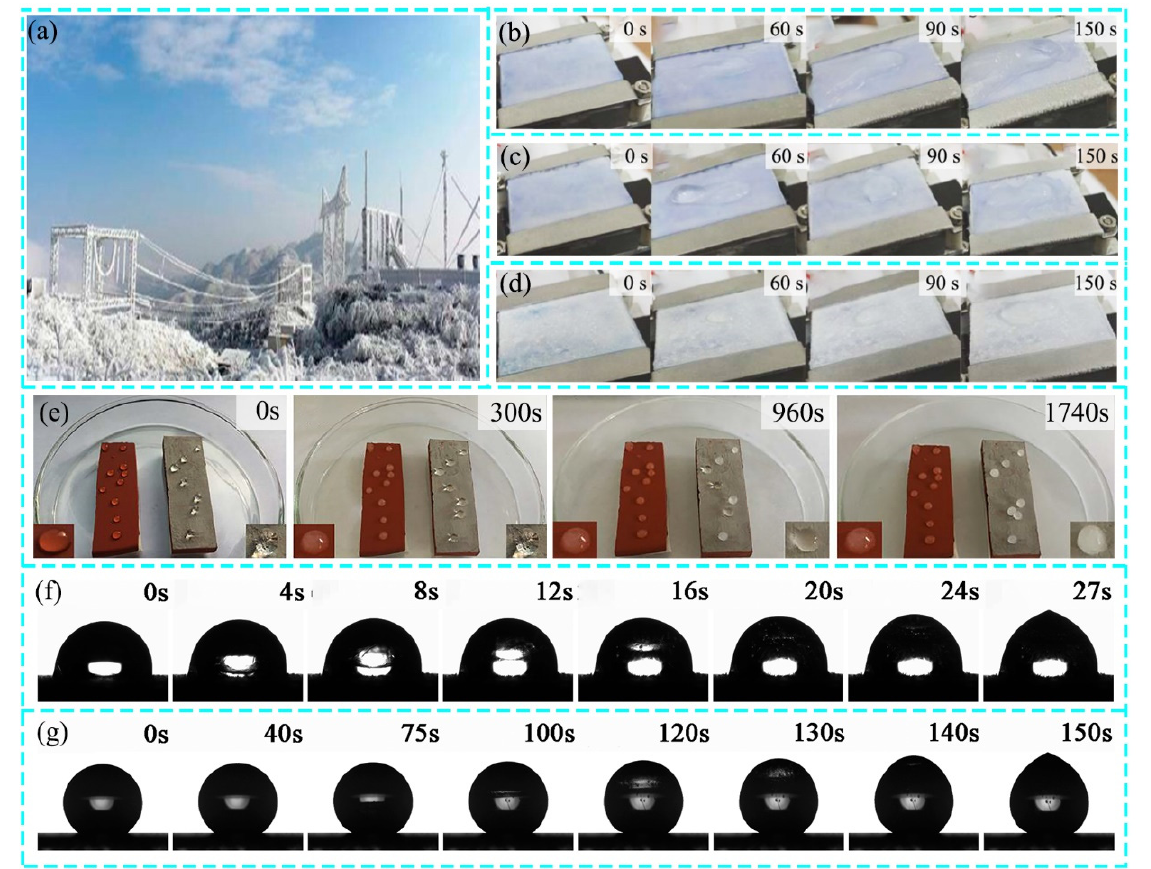
Figure 6. Effect diagram of deicing coating to inhibit icing. ( a ) A power system is damaged by snow. ( b – d ) The freezing speeds of hydrophilic, hydrophobic, and superhydrophobic surfaces at 12 °C. ( e ) Anti-icing test of coated (right) and uncoated (left) composite insulators. ( f – g ) Water droplets on different surfaces were frozen at 30 °C. ( f ) HTV silicone rubber. ( g ) SH coating.